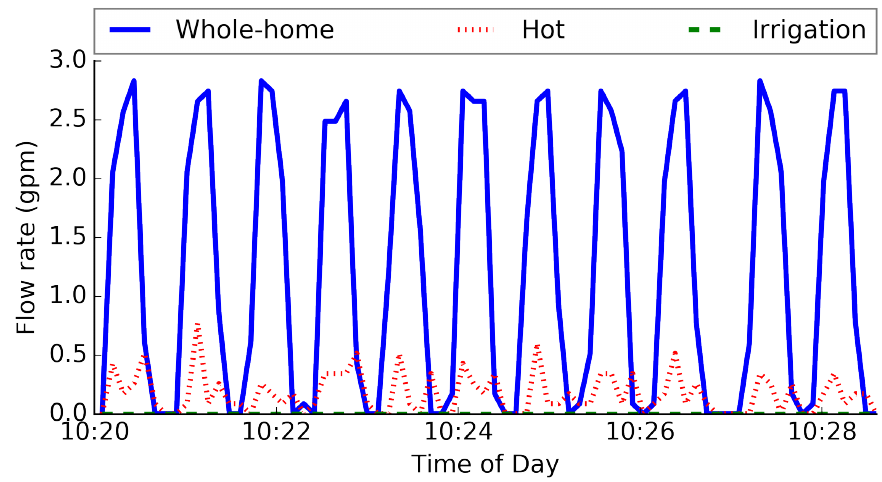
Figure 6. Non-trivial amounts of hot water use were measured during isolated toilet events